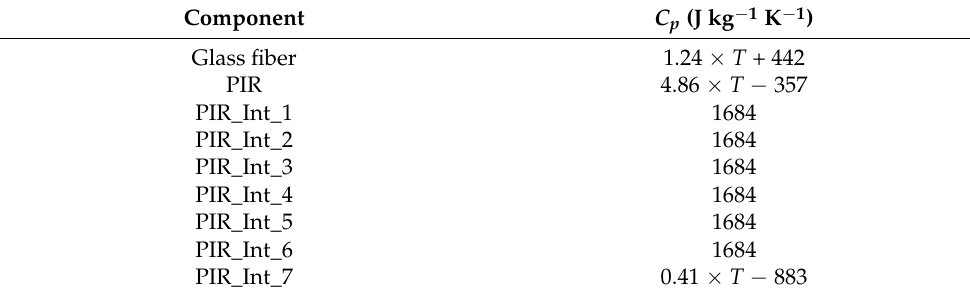
Table 2. Heat capacities of condensed-phase components of the PIR